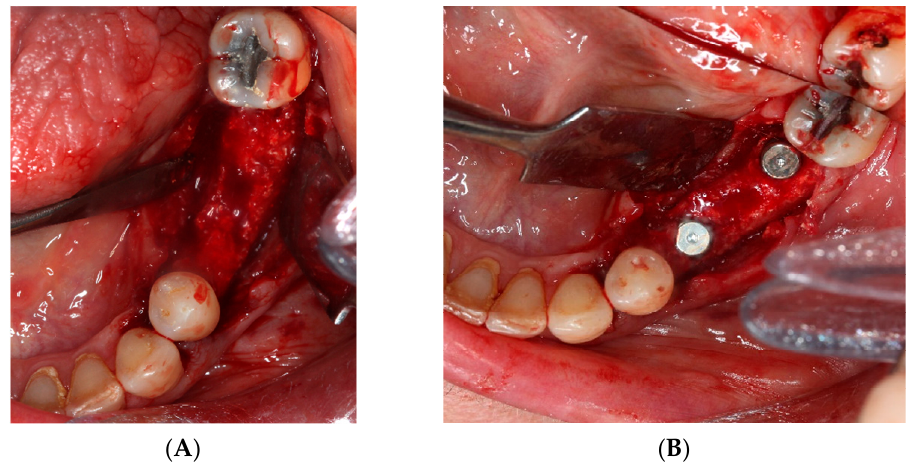
Figure 11. ( A ) Implant placement surgery ( B ) obtaining the bone trephine.